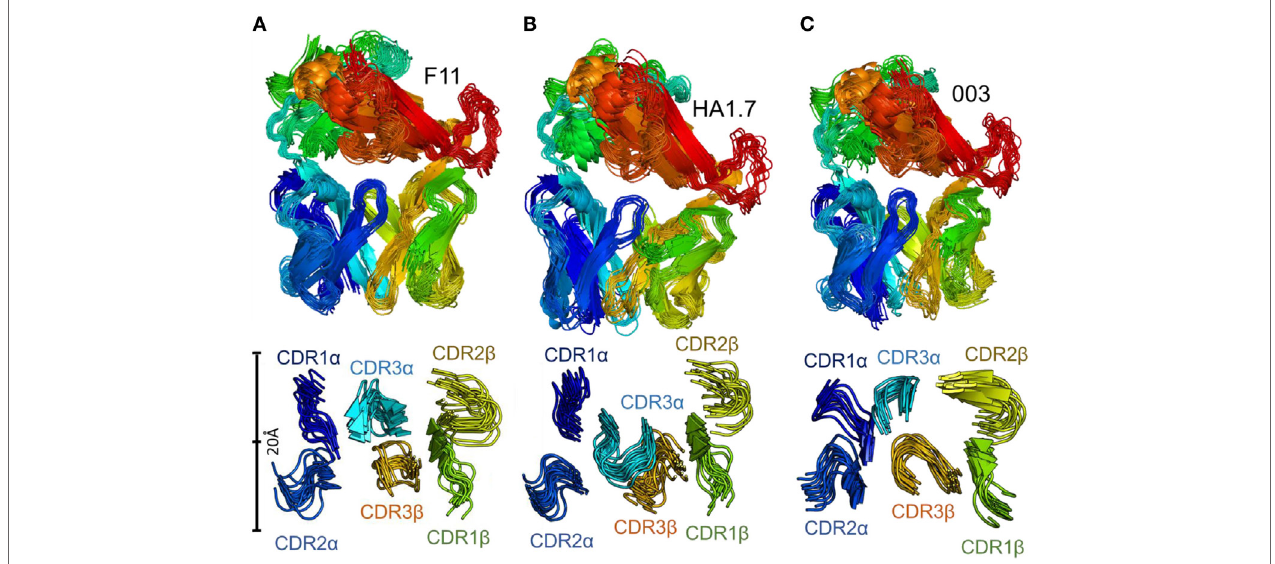
FigUre 4 | Flexibility analysis of the unbound F11, HA1.7, and 003 T cell receptor (TCRs). The TCRs were subjected to analysis using the FRODA/FIRST software packages to investigate protein flexibility. The top panels show the overall conformation of each TCR, using a single dataset, in which the TCR could flex over up to 2,000 frames, or until the run stopped because of steric clashes or overextended constraints. The bottom panel displays only the CDR loops of each TCR, with a distance scale to measure the motions, using the same analysis. (a) F11 TCR. (b) HA1.7 TCR. (c) 003 TCR. All structures are colored by protein domain, with the CDR1 α in dark blue, CDR2 α in blue, CDR3 α in cyan, CDR1 β in green, CDR2 β in yellow, and CDR3 β in